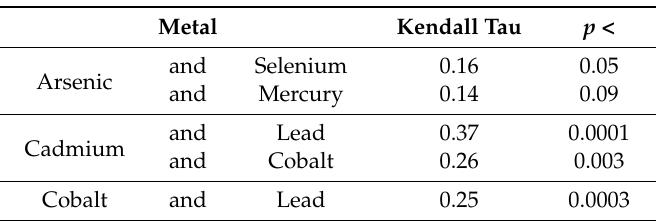
Table 2. Correlations of trace elements in the blood of semipalmated sandpipers from Suriname. ( n = 71) For all other combinations p >